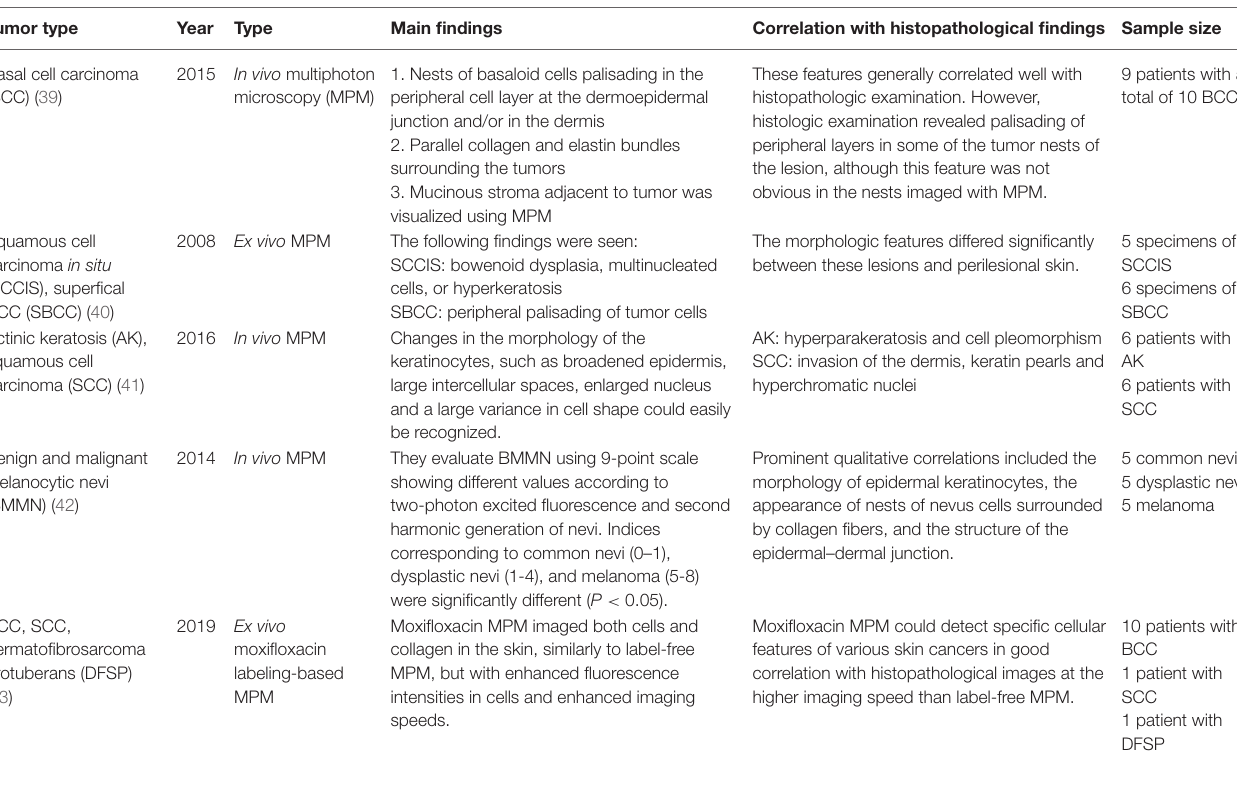
TABLE 6 | Key articles comparing multiphoton microscopy and